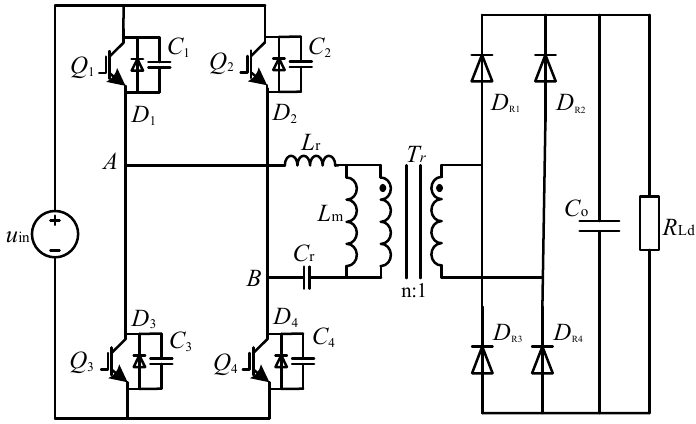
Figure 7. Circuit topology diagram of full-bridge LLC resonant converter.